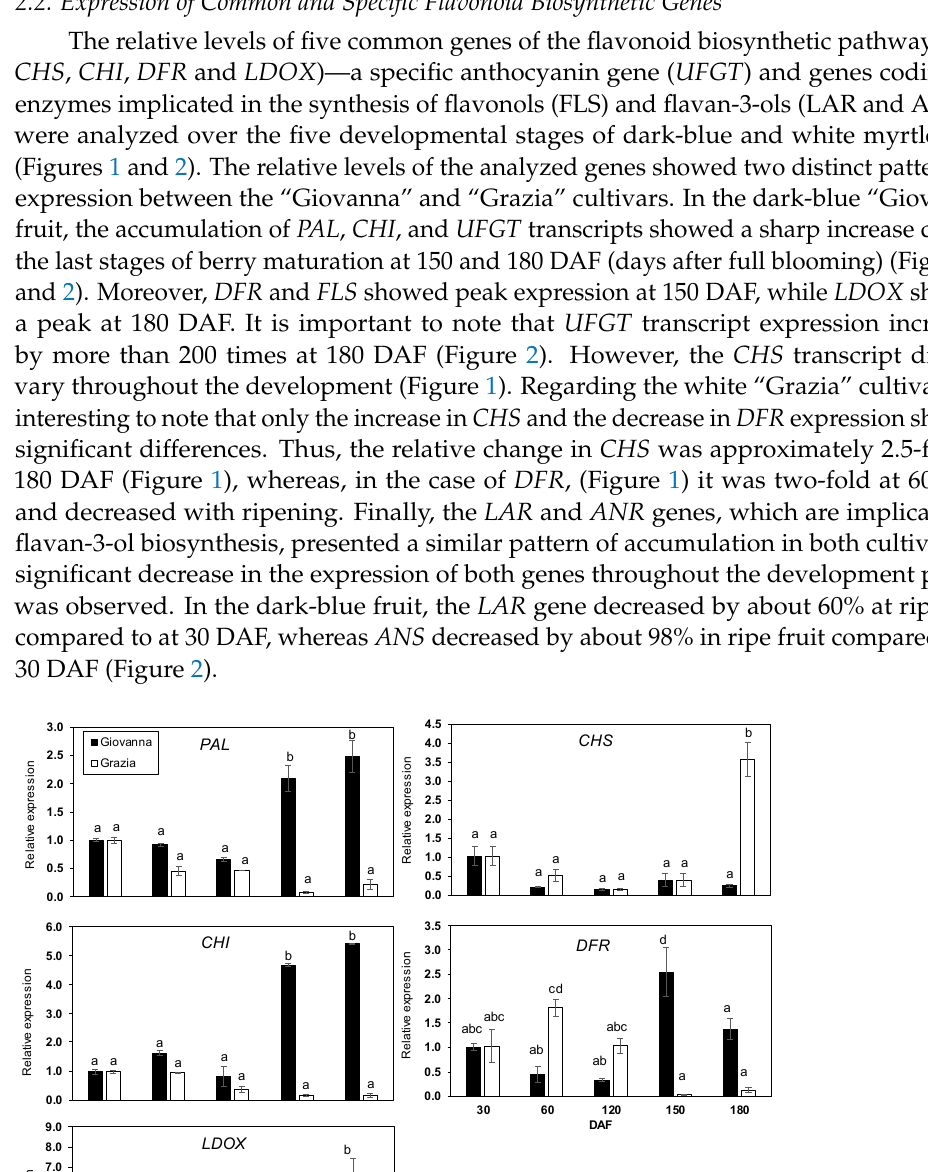
Figure 1. Expression analysis of PAL , CHS , CHI , DFR , and LDOX during five stages of “Giovanna” (dark-blue) and “Grazia” (white) myrtle fruit development. Transcript levels of each gene were assessed by RT-qPCR and normalized using actin as a reference gene. The results were calculated relative to a calibrator sample (30 days after full blooming (DAF) from dark-blue samples) using the formula 2 − ∆∆ Ct . Error bars represent standard error of three biological replicates. Every replication consisted of 40 berries. Different letters represent statistically significant differences with Tukey’s B-test ( p < 0.05). Tukey’s B-test was carried out by comparing all means calculated at different DAFs for both